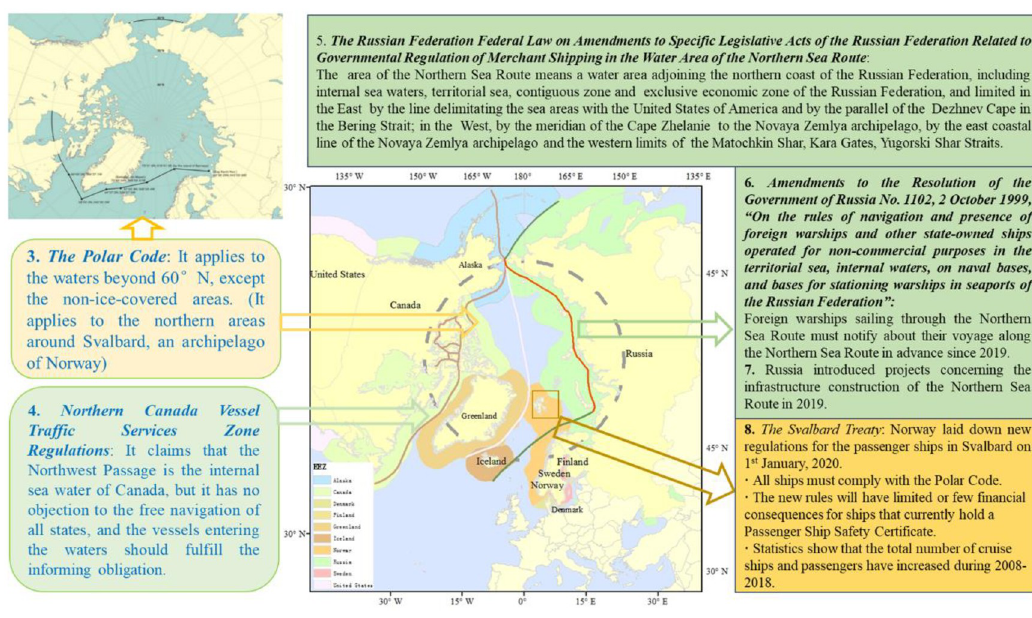
Fig 6. Example of laws and regulations spatial match. The boundary was obtained from Natural Earth (http://www. naturalearthdata.com/). https://www.britannica.com/place/Arctic/The-people.